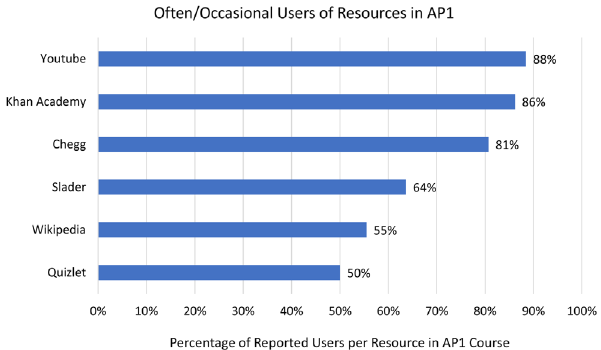
FIG. 11. Percentage of resource users who reported often or occasional usage frequency of that resource in Analytical Physics ¼ 427 ). 1 ( N AP 1